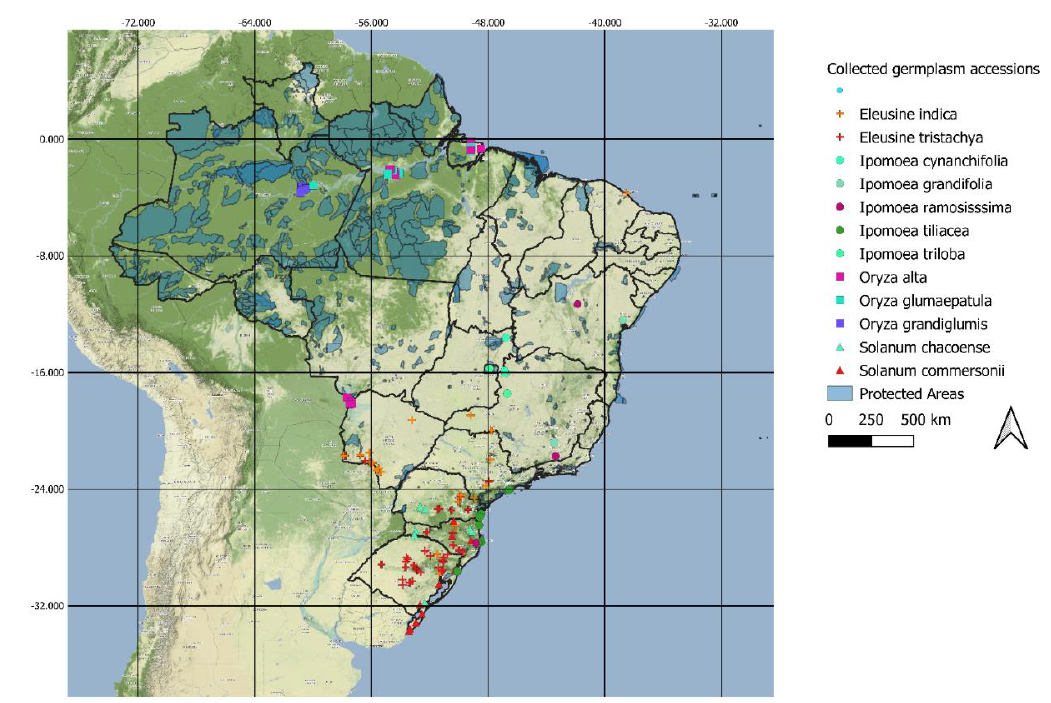
Figure 2. Geographic distribution of germplasm collection for Oryza, Ipomoea , Eleusine, and Solanum species from 2016 to 2018. Table 4. Collected accessions of Oryza, Solanum, Eleusine, and Ipomoea wild species.